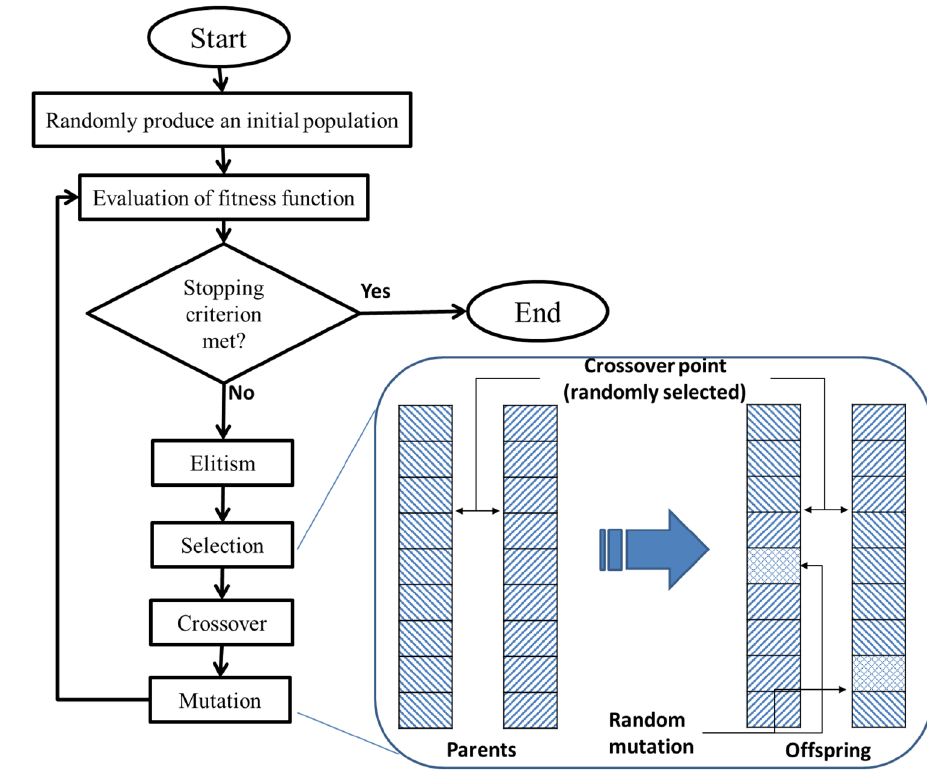
Fig. 21 Flowchart of GA (Jafarizadeh et al.